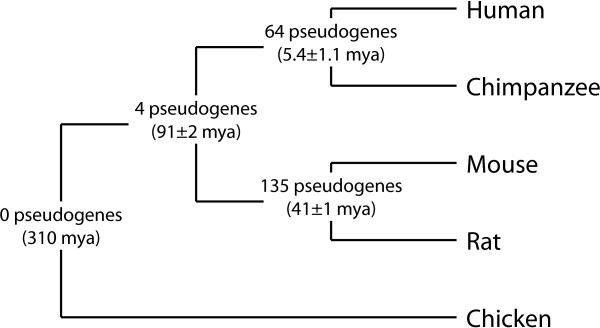
Phylogeny and numbers of syntenic pseudogenes. Phylogenic tree relating human, chimpanzee, mouse, rat, and chicken. Branch points are labeled with the number of syntenic GAPDH pseudogenes between the two branches and the approximate date of divergence. Branch lengths are not drawn in proportion to elapsed time.